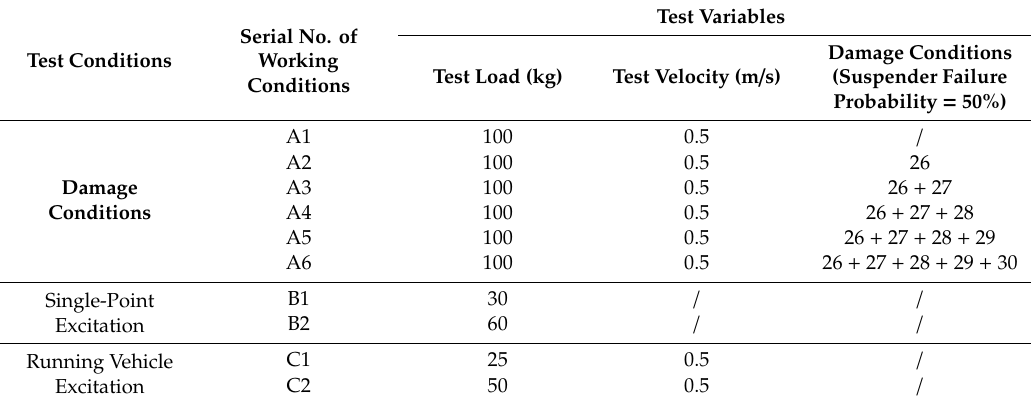
Table 1. Test conditions and content.